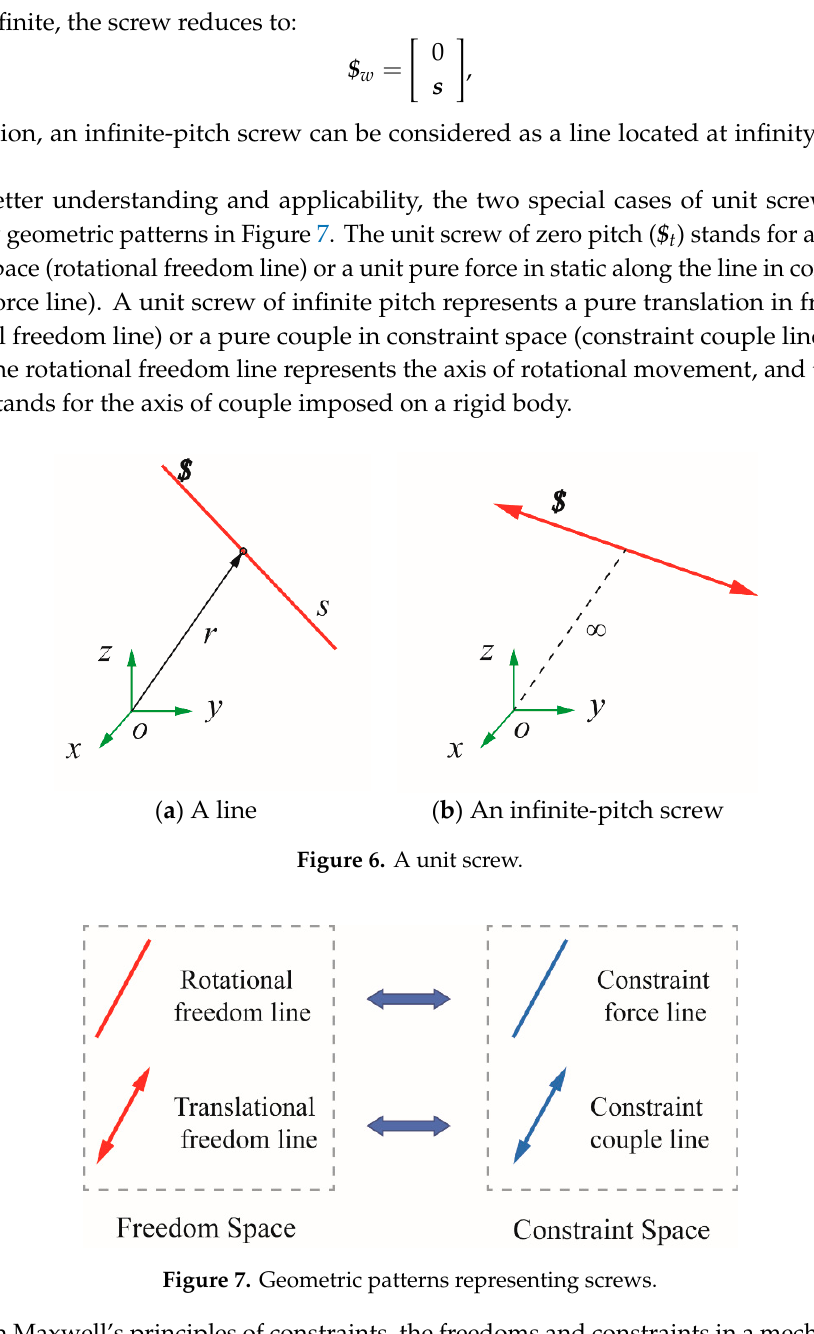
Figure 7. Geometric patterns representing screws.